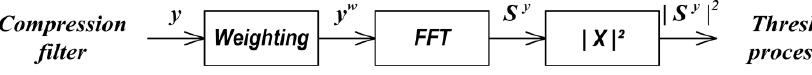
Fig. 1. FFT-based MTI